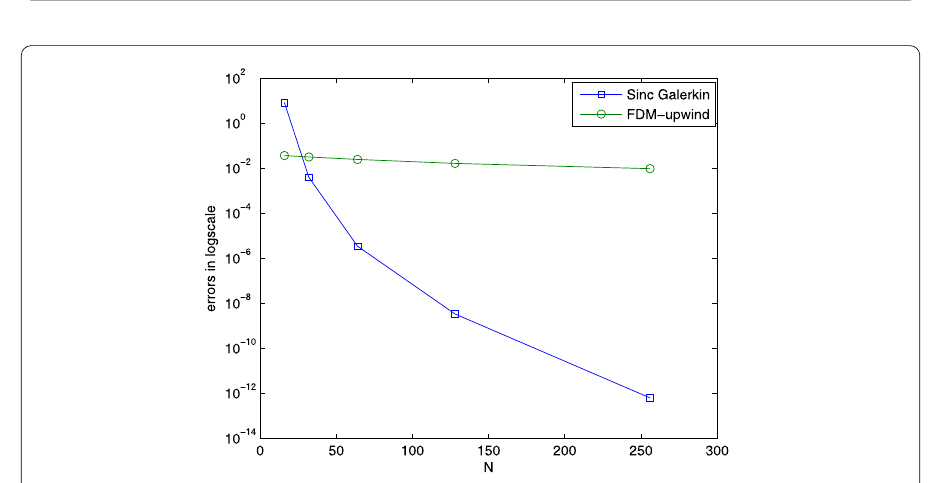
Figure 3 Convergence of the sinc-Galerkin and FDM-upwind methods for various values of N with α = 0.5, (cid:4) = 2 –5 , τ = 1/500